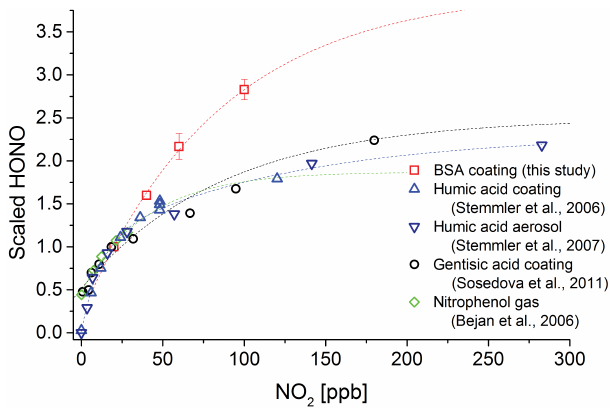
Figure 5. Comparison of HONO formation dependency on NO 2 at different organic surfaces. HONO concentra- tions are scaled to the HONO concentration at 20ppb NO 2 / [ HONO ] NO ( [ HONO ] NO ). The red squares indicate BSA 2 2 = 20ppb coating (16µgcm − 2 ) at 161Wm − 2 and 50% RH (this study). Blue triangles pointing up are humic acid coating (8µgcm − 2 ) at 162Wm − 2 and 20% RH (Stemmler et al., 2006), while the blue triangles pointing down are the humic acid aerosol with 100nm diameter and a surface of 0.151m 2 m − 3 at 26% RH and 1 × 10 17 photonscm − 2 s − 1 (Stemmler et al., 2007). The black circles are gentisic acid coating (160–200µgcm − 2 ) at 40–45% RH and light intensity similar to that in the humic acid aerosol study (Sosedova et al., 2011). Green diamonds are ortho-nitrophenol in gas phase (ppm level) illuminated with UV/VIS light. Dotted lines are exponential fittings of the measured data points and are meant to guide the